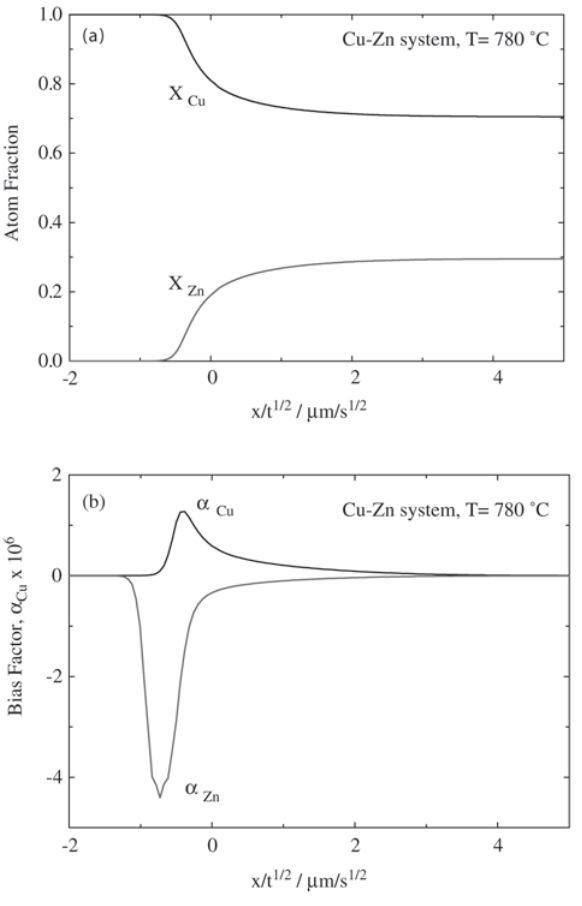
Figure 12. a) Composition profiles for the Cu-Zn system and b) bias factors obtained from the biased flux shown in Fig.